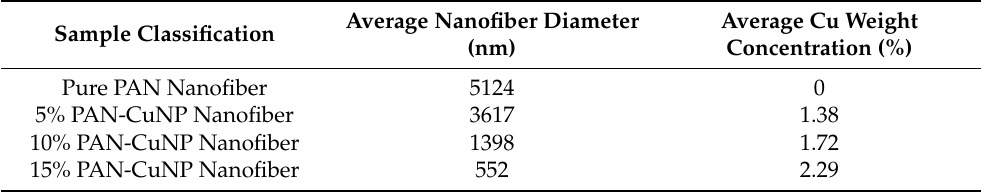
Table 1. Average Nanofiber Diameter and Average Copper Weight Concentration for PAN-CuNP nanofibers Synthesized from Different wt.% of CuSO 4 Over Five Trials.